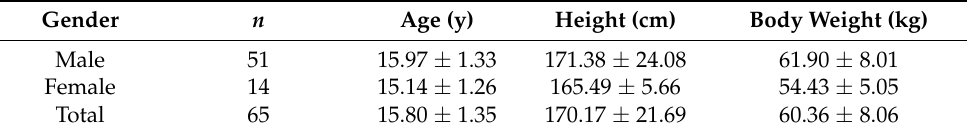
Table 1. Basic Profiles of All Athletes.